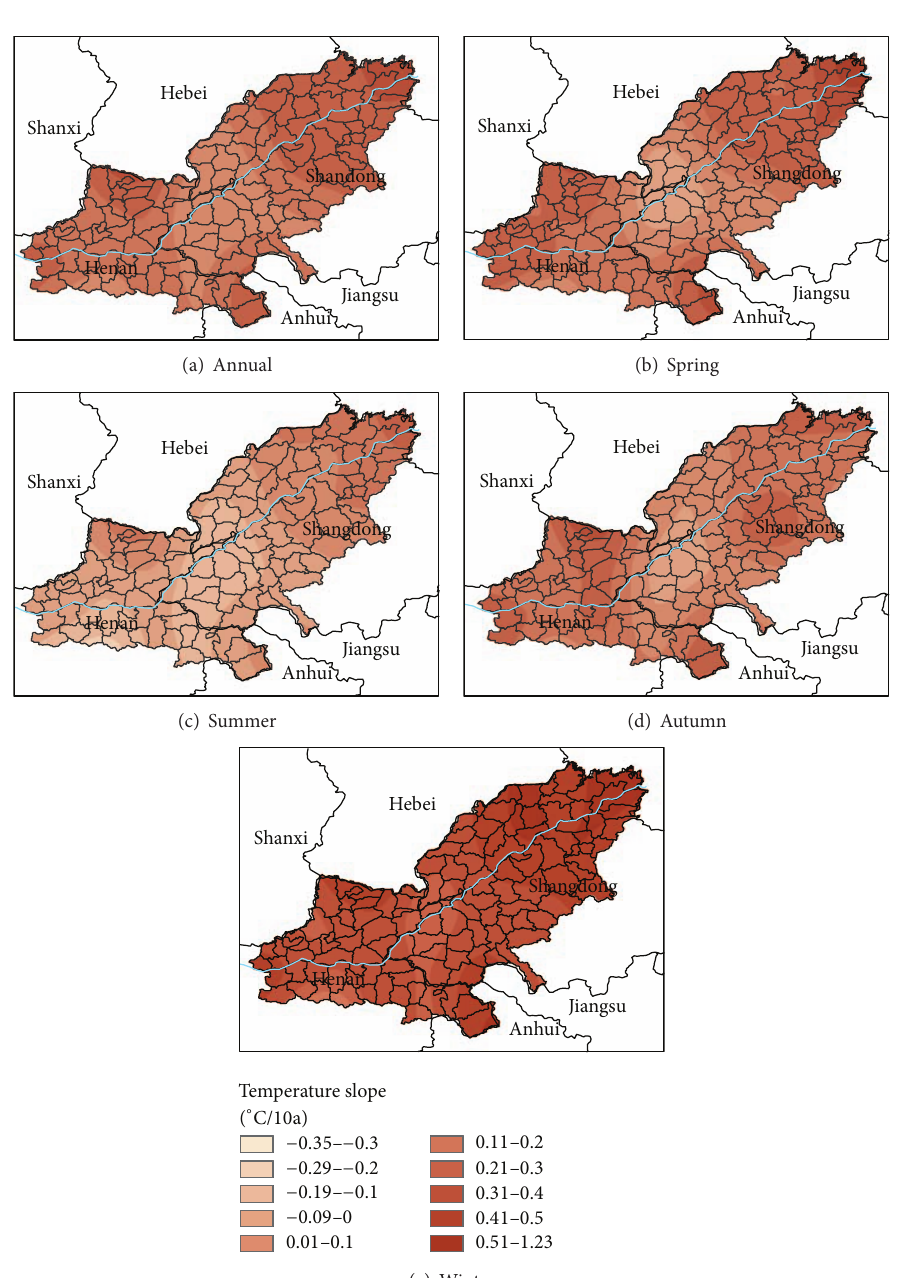
Figure 7: Spatial Distribution of annual temperature trend rates in the Lower Yellow River Region from 1960 to